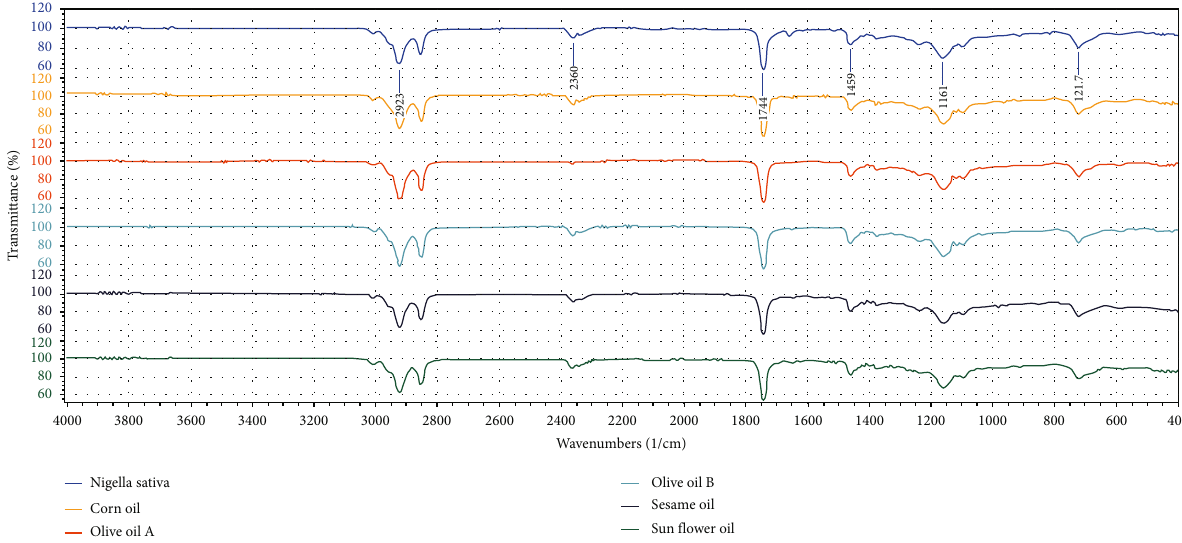
Figure 6: FTIR spectra of olive cooking oil A, olive cooking oil B, Nigella sativa, sesame oil, corn oil, and sun fl ower